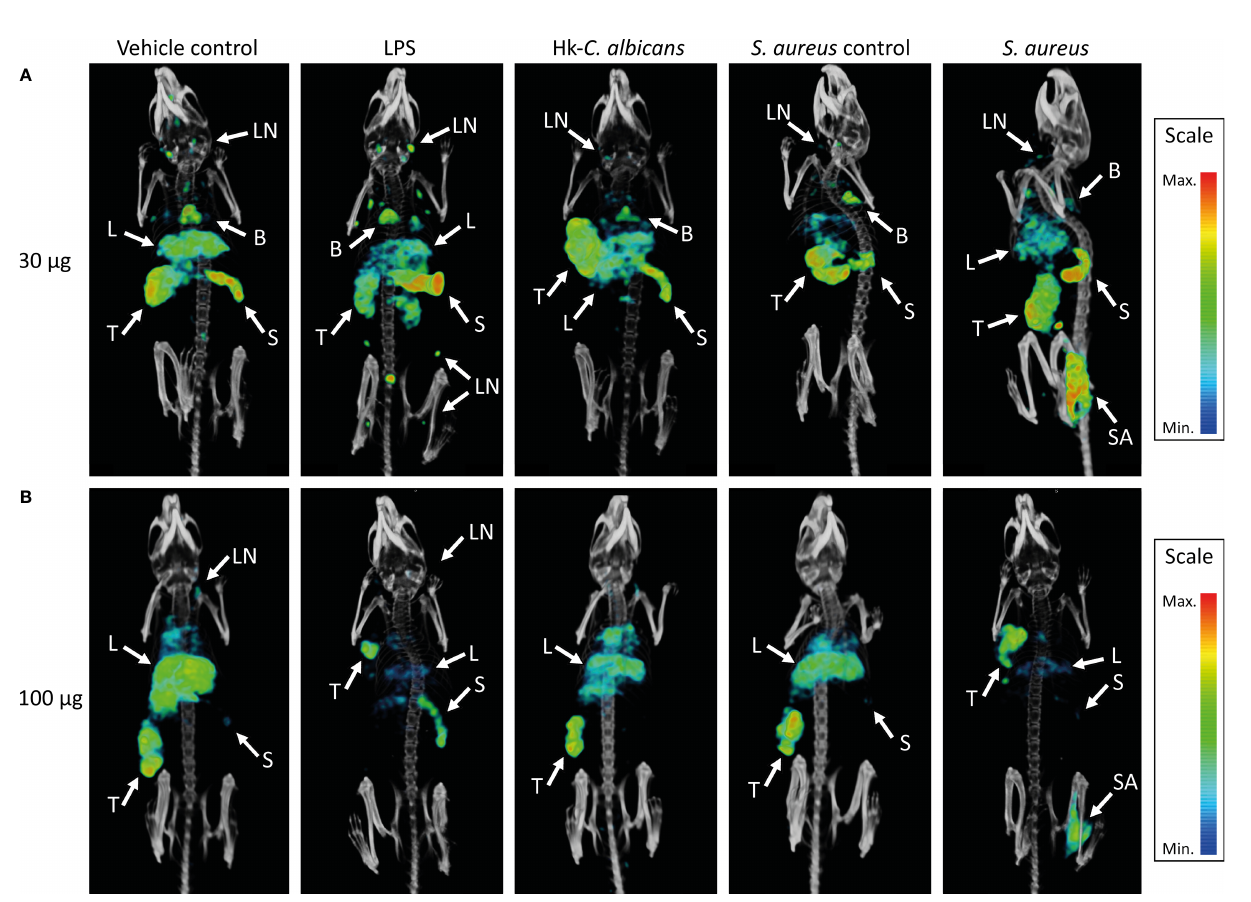
FIGURE 3 | SPECT/CT images showing the in vivo distribution of 111 In-mPD-L1 in vehicle-injected and LPS-stimulated, Staphylococcus aureus -infected, or Hk- C. albicans -stimulated RenCa tumor-bearing mice. Representative MIPs of vehicle control, LPS-stimulated, S. aureus -infected, and Hk- C. albicans- stimulated RenCa tumor-bearing BALB/c mice, 1 day after injection 30 µg of 111 In-mPD-L1 (A) or 100 µg of 111 In-mPD-L1 (B) . Tissue uptake of 111 In-mPD-L1 is visualized with MIP thresholded microSPECT/CT images; all images were generated using the same MIPs threshold. Uptake of 111 In-mPD-L1 can be appreciated in tumor (T), spleen (S), S. aureus -infected (SA), lymph nodes (LN), liver (L), and brown adipose tissue B. LPS, lipopolysaccharide; Hk- C. albicans , heat-killed Candida albicans ; SPECT, single-photon emission CT; MIPs, maximum intensity